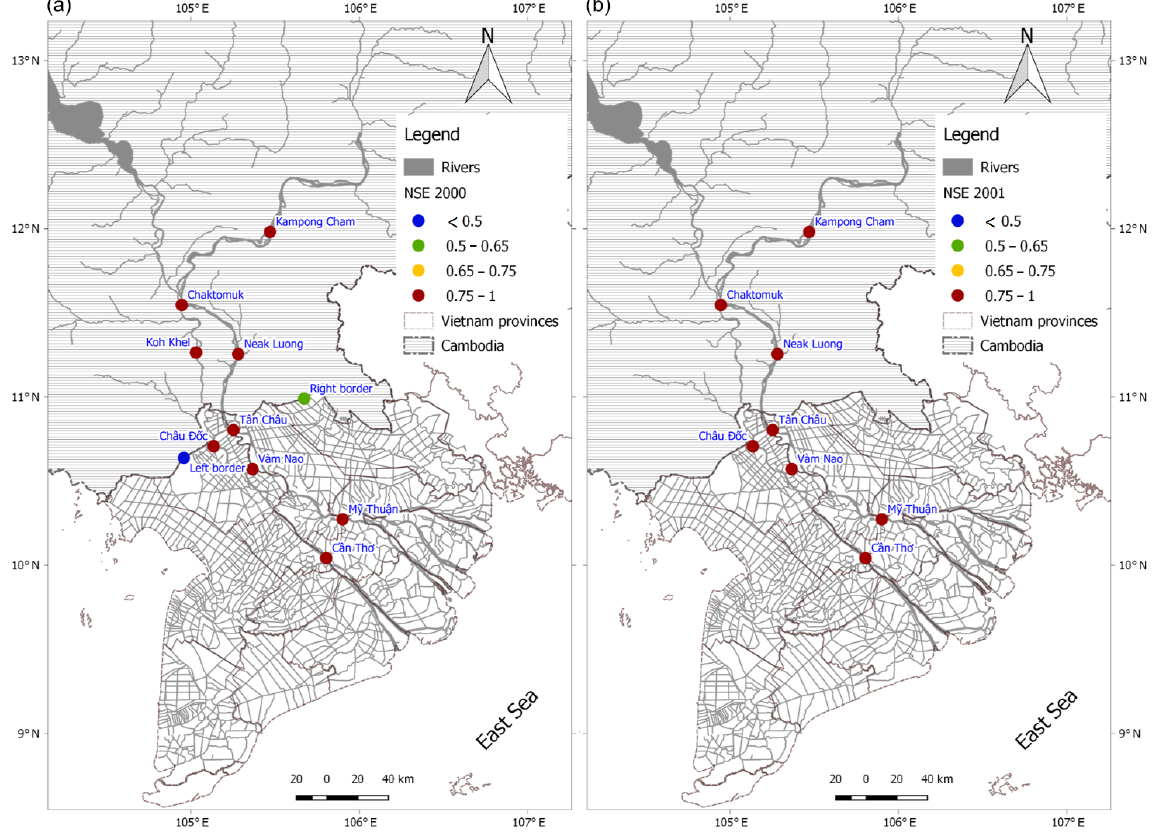
Figure A2. The NSE values of the water discharges at the gauging stations in the Mekong Delta. The calibration (the year 2000) and validation (the year 2001) are presented in panels (a) and (b) respectively.